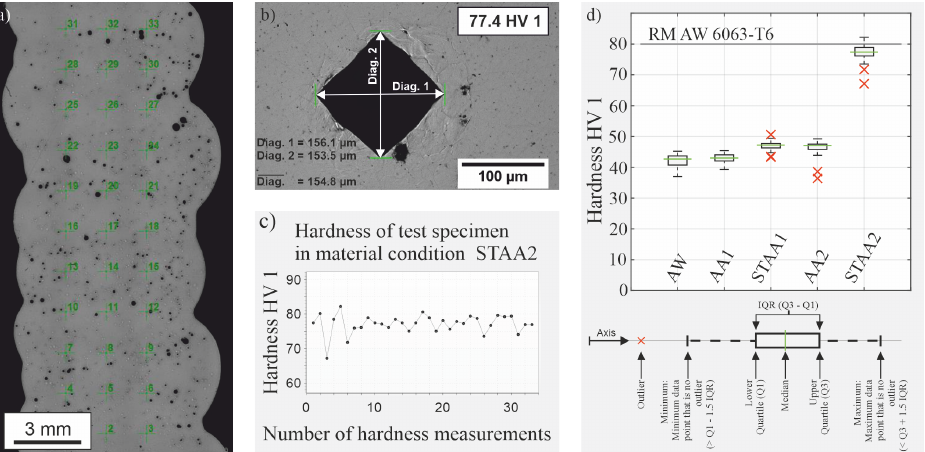
Figure 6. ( a ) Cross-section with the pattern of hardness indentations, ( b ) visualization of the hardness indent, ( c ) hardness HV 1 of the test specimen in material condition STAA2 and ( d ) hardness HV 1 of WAAM samples in different material conditions compared to the hardness of the RM AW